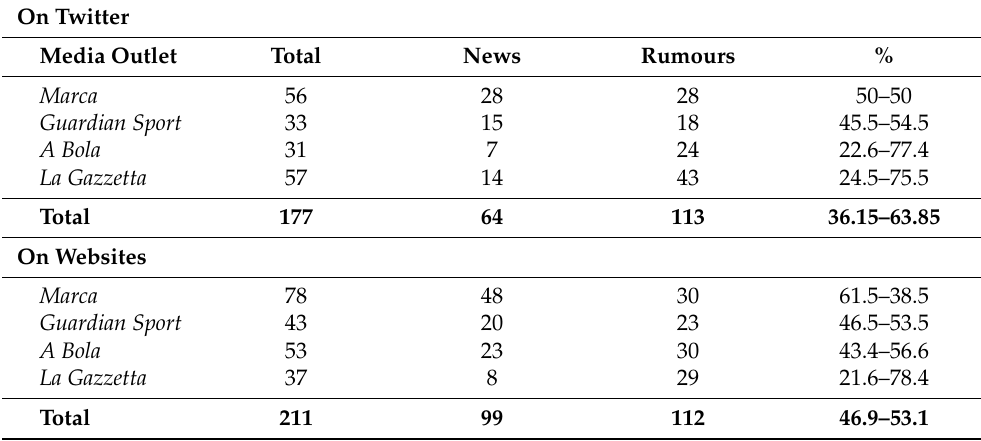
Table 1. The table shows the distribution among the four news outlets of pieces of news and rumours published during the 2020 winter football transfer